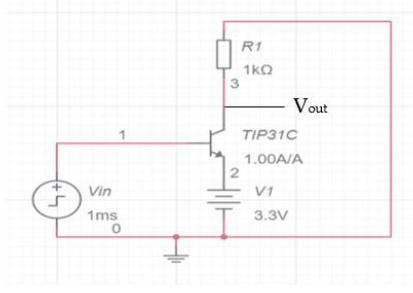
Figure 5. Laser Driver Circuit.